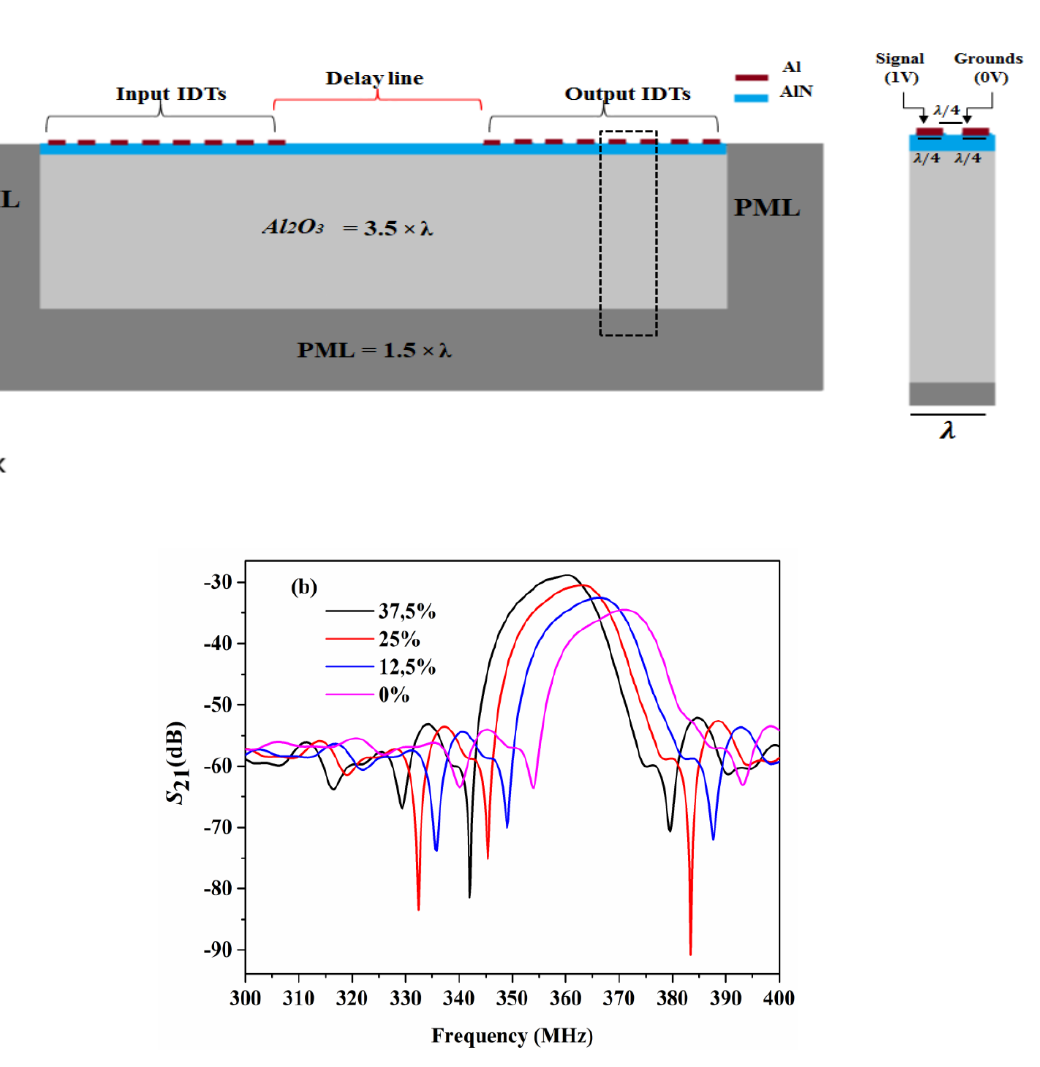
Figure 12. ( a ) 2D model used for the calculation of the transmission using the IDT. The PnC was set between the input and output IDTs. ( b ) Insertion loss ( S 21 ) for different values of Sc concentration x of the non-structured surface.